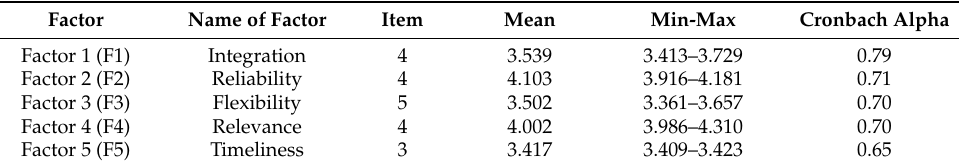
Table 6. Cronbach alpha values (Source: IBM SPSS ® authors’